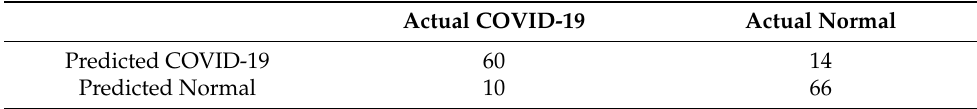
Figure 9. Accuracy and AUC of transfer learning models for COVID-19 detection from chest CT scans. Table 6. Confusion matrix for performance of VGG16 on CT scans.